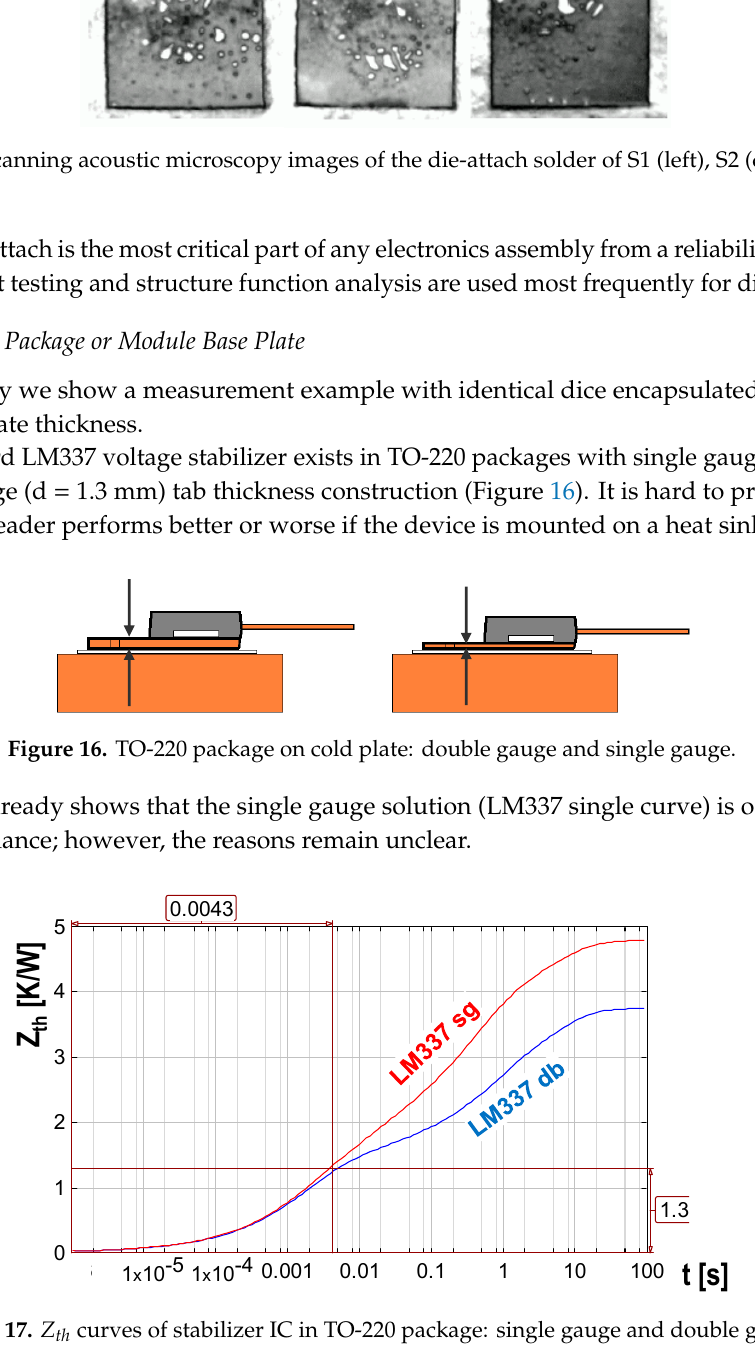
Figure 14. Die-attach comparison of three MOSFET samples (S1, S2, S3).